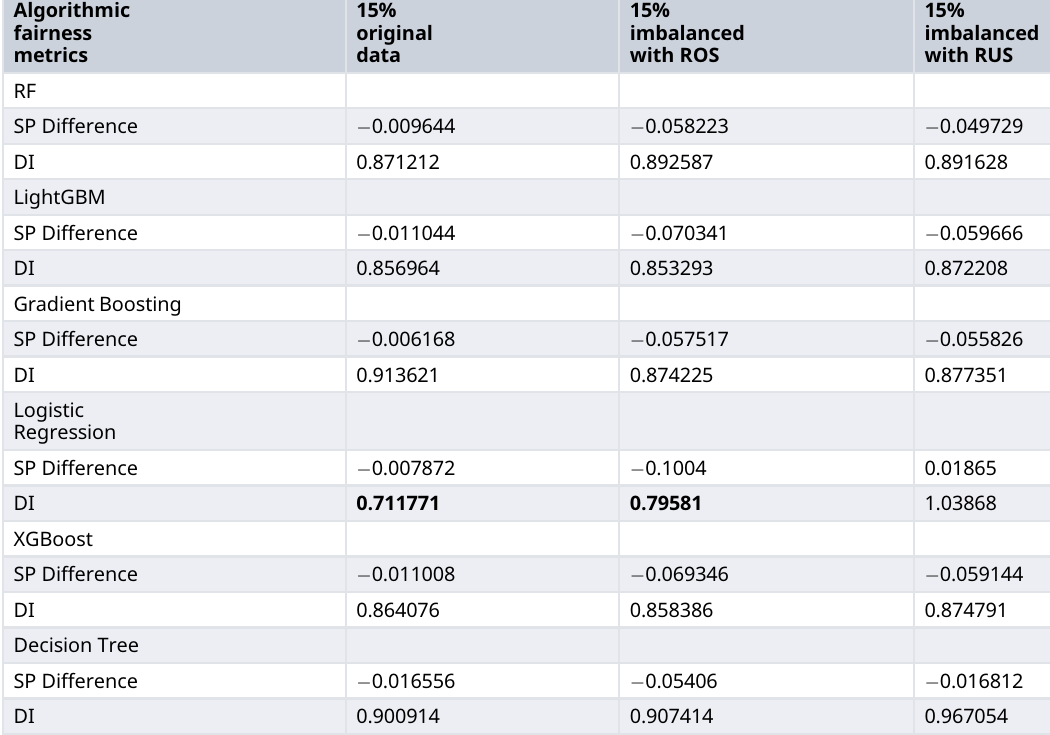
Table 7. The algorithmic fairness measures on 15% unbalanced dataset. Algorithmic